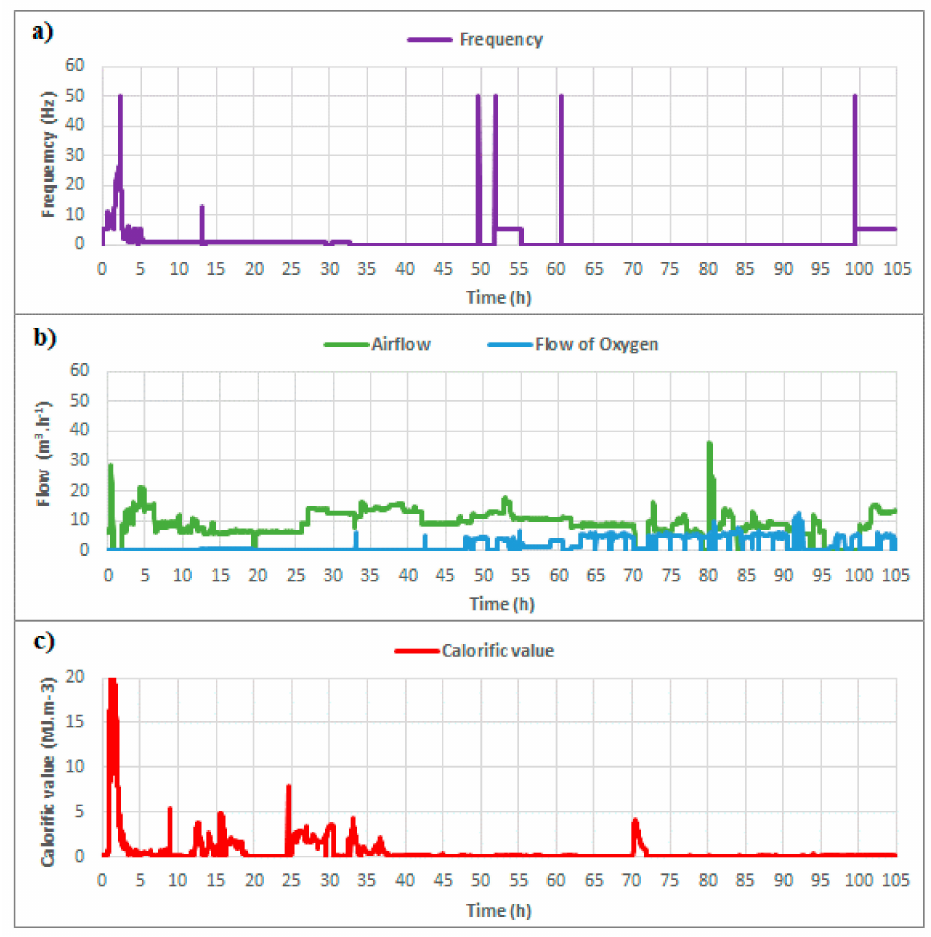
Figure 9. The measured data behaviors in the second experiment: ( a ) the exhaust fan motor frequency, ( b ) the air and oxygen, and ( c ) the calorific value (Source: own elaboration). Table 4. Coefficients of regression models for channel temperatures and values of a multiple coefficient of determination and a standard error of the estimate (Source: own